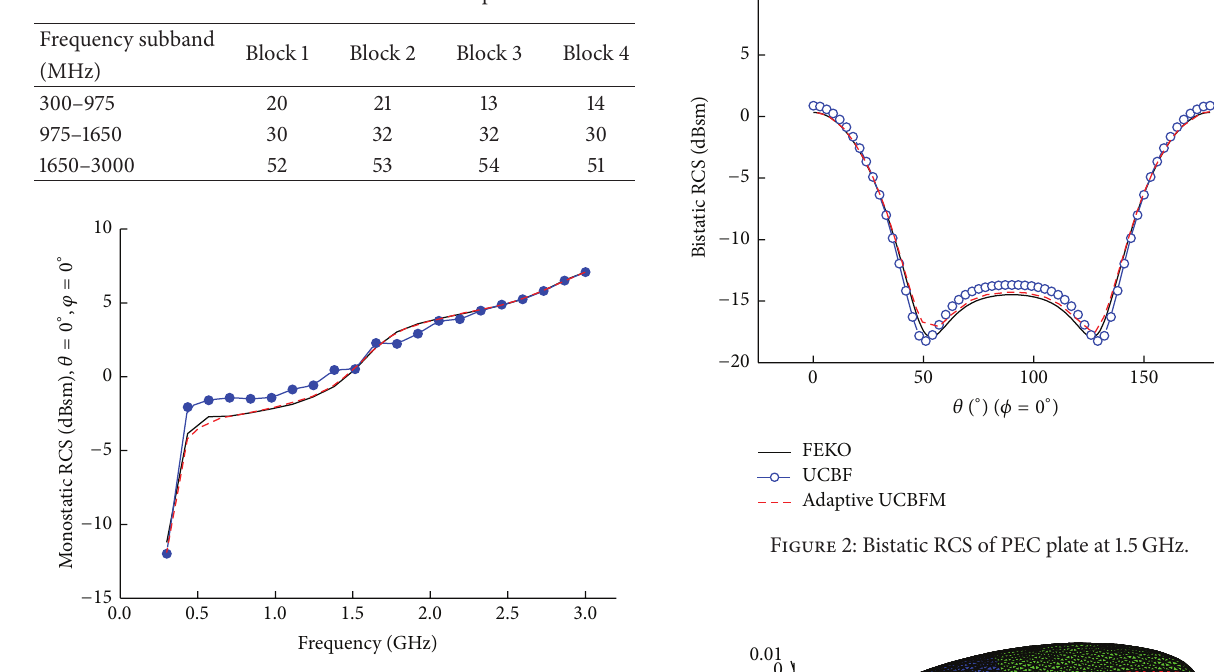
Table 1: Number of the UCBFs of the plate.